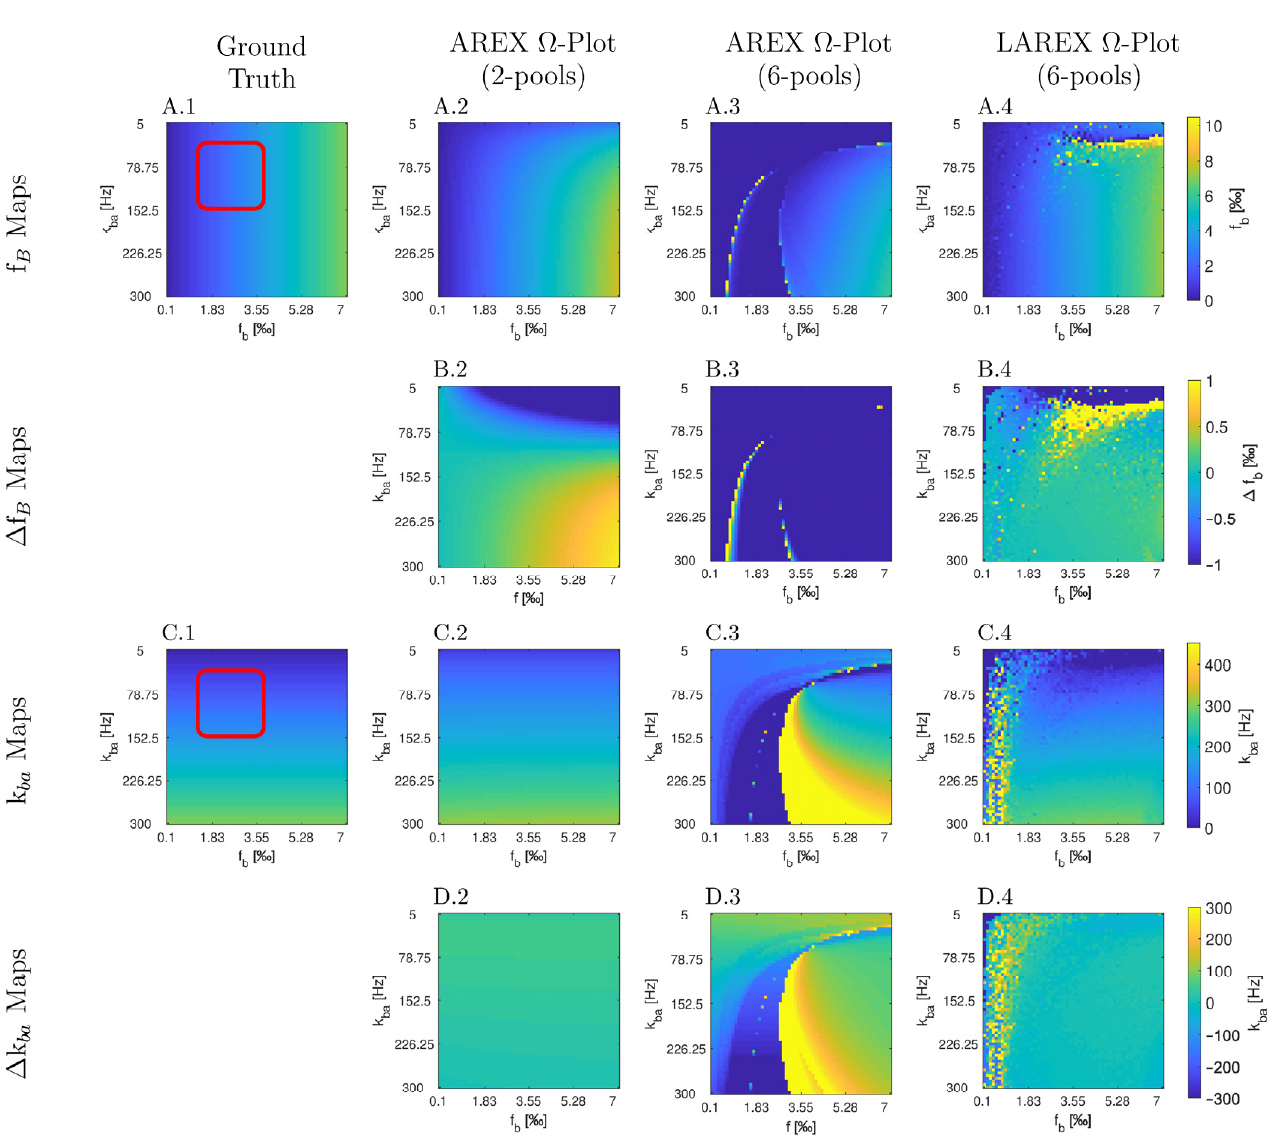
Figure A2. In silico Appendix Study 2—APT qCEST analyses of gray matter of the visual cortex. Parameter maps ( A , C ) and color-coded error maps ( B , D ) for fractional APT concentrations f b and exchange rates k ba as a function of f b and k ba . The study was performed using a 4-pool system and a field strength of 7 Tesla. The parameters of the exchanging proton pools were: Water (T 1 = 2000 ms, T 2 = 55 ms, and ∆ = 0 ppm); APT (T 1 = 1000 ms, T 2 = 10 ms, f = variable between 0.001–0.01, k ba = variable between 0–300 Hz, and ∆ = 3.5); NOE (T 1 = 1000 ms, T 2 = 0.3 ms, f = 0.06, k ba = 10 Hz, and ∆ s = − 3.5 ppm); MT (T 1 = 1000 ms, T 2 = 10 µ s, f = 0.11, k ba = 50 Hz, and ∆ = 0 ppm), and were based on the results of Mougin et al. [67]. Furthermore, analogous to the in silico, in situ, and in vivo experiments, the same MR parameters (TR = 2500 ms, TE = 3.5 ms) and presaturation parameters (n p = 40, t p = 100 ms, t d = 100 ms, presaturation pulse shape = Gaussian, ∆ ω = 5 ppm) were